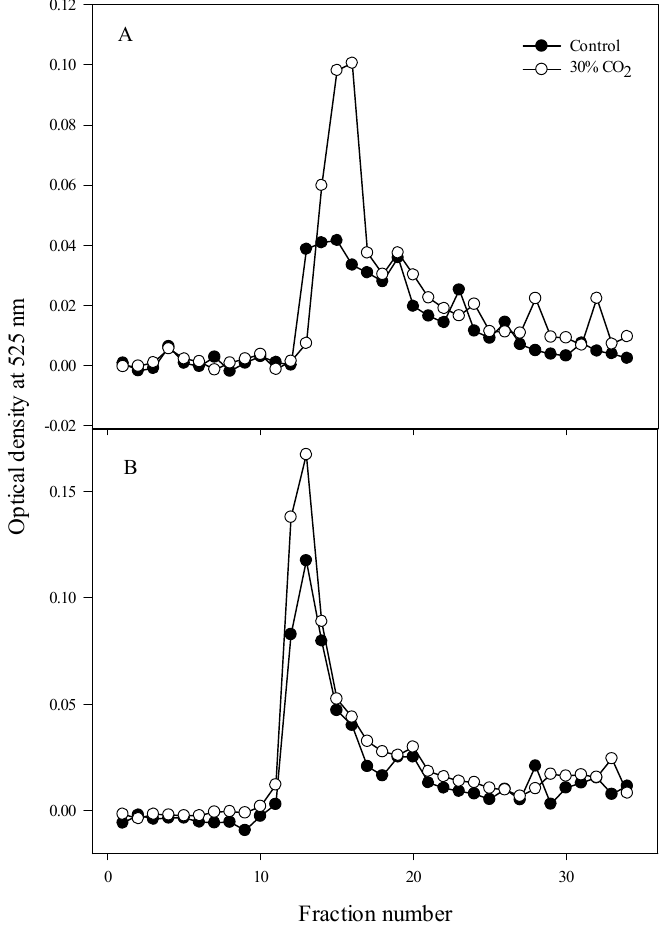
Figure 4. Size distribution of galacturonic acids in water-soluble pectin from strawberry fruits treated with 30% CO 2 for 3 h, as well as control fruits. ( A ) 3 h after treatment; ( B ) 10 days after